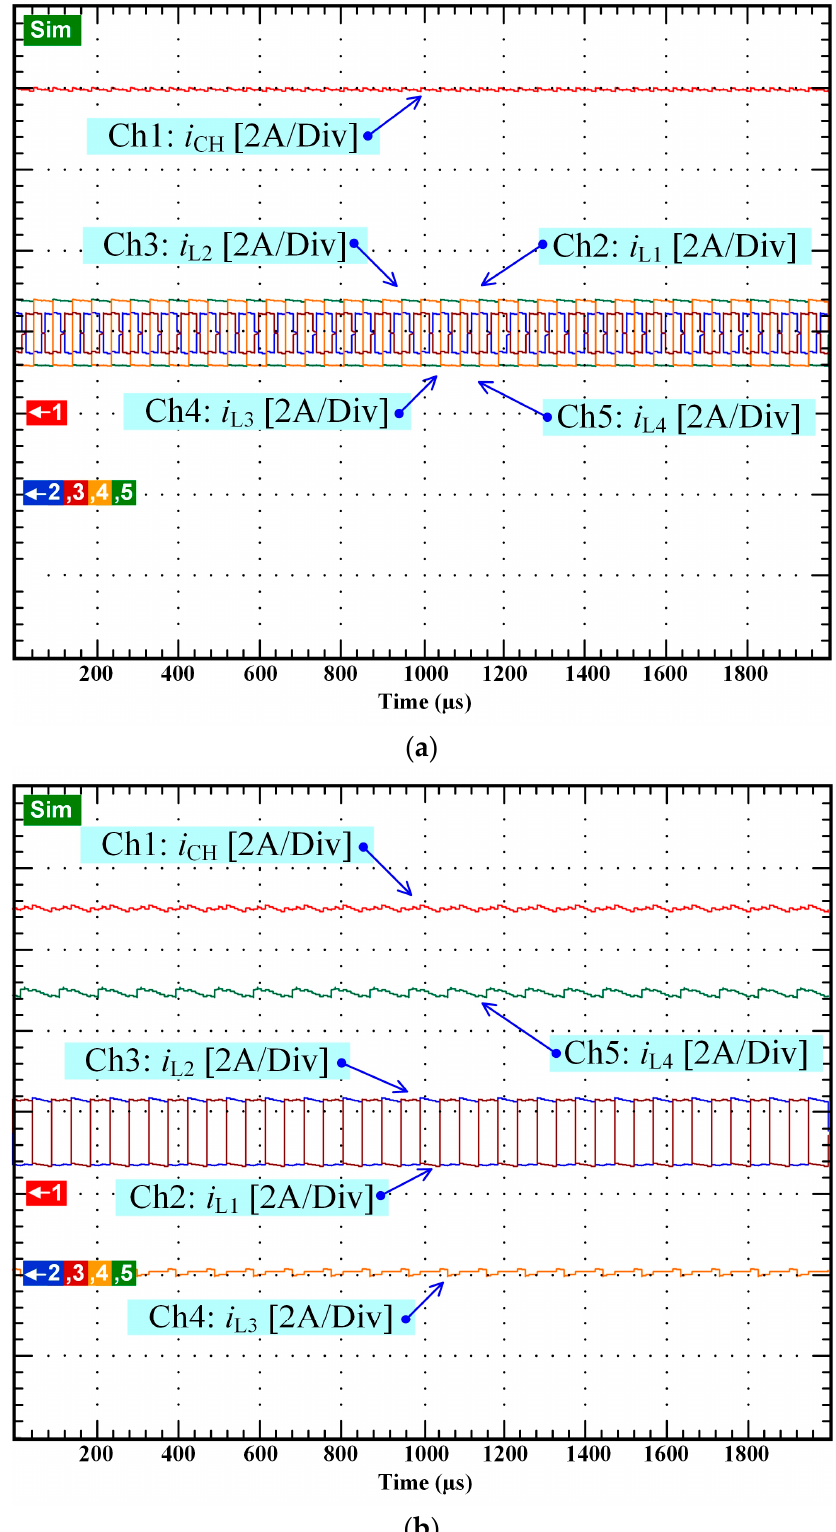
Figure 4. Simulation results: ( a ) healthy operation 1; ( b ) operation when an OCF occurs with unmodified control showing a performance degradation in terms of the output current.